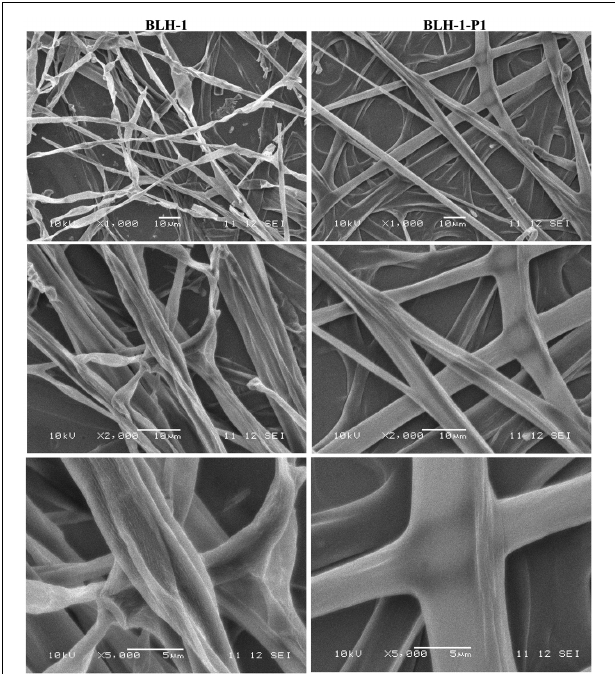
FIGURE 6 | Electron micrographs of hyphal morphology of the dsRNA-containing strain BLH-1 and dsRNA-free strain BLH-1-P1. The (top, middle, and lower panels) are photographs captured at 1000 × (scale bar: 10 µ m), 2000 × (scale bar: 10 µ m) and 5000 × (scale bar: 5 µ m) magnification. The images were taken from the ultrathin sections of hyphae collected from the actively growing margins of colonies cultured for 5 days on PDA at 27 ◦ C.